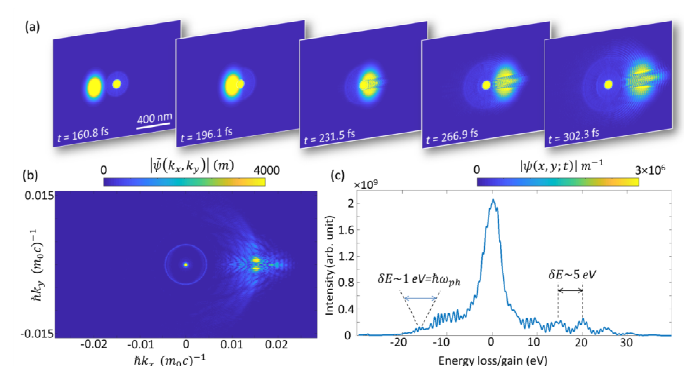
Fig. 2. (a) Snapshots of the dynamics of a low-energy electron wave function during its interaction with the laser-triggered oscillations of Fermi electrons in a carbon nanorod, (b) The momentum-space representation of the total wave function, after interaction of the electron probe with the sample, (c) The total energy distribution of the electron integrated over the lateral direction, after the interaction.